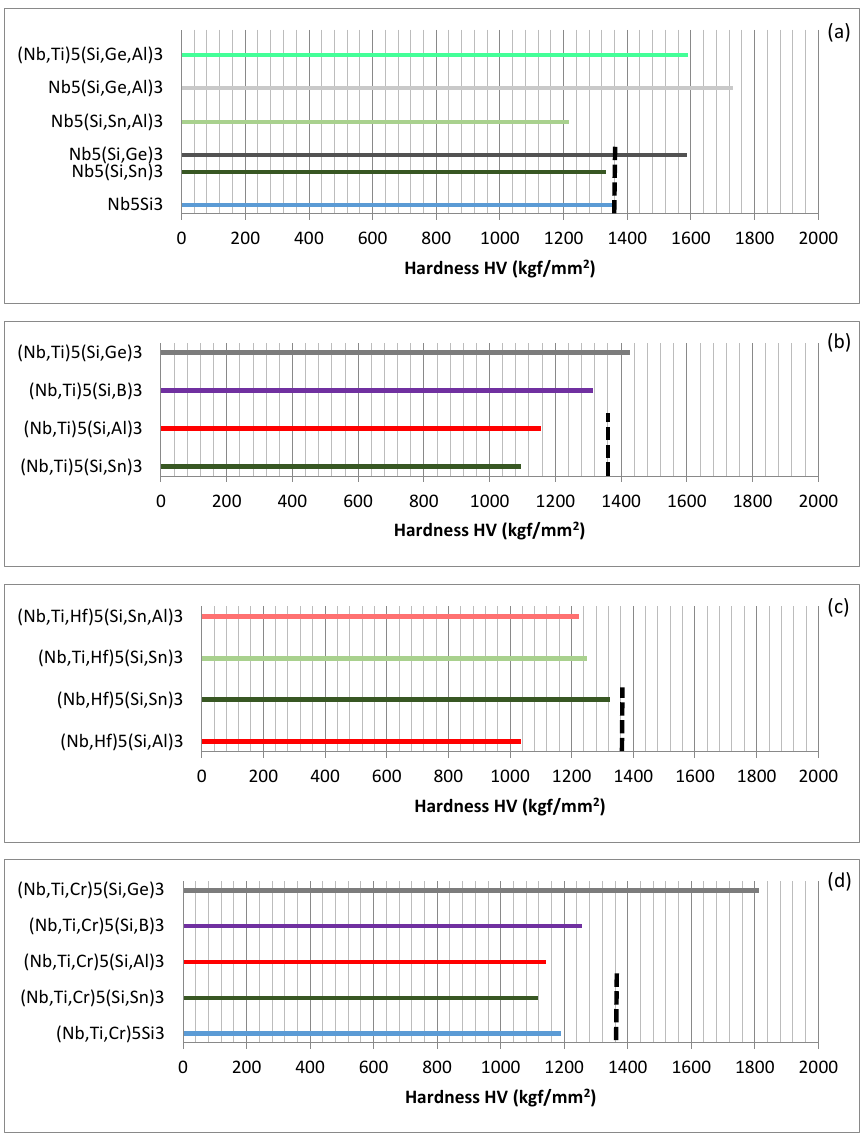
Figure 3 Figure 3. Bar charts showing the average Vickers hardness (HV) of tetragonal Nb 5 Si 3 . The vertical dashed lines indicate the hardness of binary (unalloyed) Nb 5 Si 3 . In the parts ( a ), ( b ), ( c ) and ( d ) the data is from [44,45,50], [29,46], [45,51], [46,47], respectively. Table 4. Vickers hardness HV (kgf/mm 2 ) of unalloyed Nb 5 Si 3 and alloyed (Nb,Ti) 5 Si 3 (Ti = 12.5 at.%) and unalloyed Ti 5 Si 3 . The HV *, HV + and HV C were calculated in GPa using HV* = (1 − 2 ν )E/[6(1 + ν )], HV + = 2[(G/B) 2 G] 0.585 − 3 and HV C = 0.151 G [55] and the data for B, E, G and ν from [19,42] and were converted to Vickers hardness